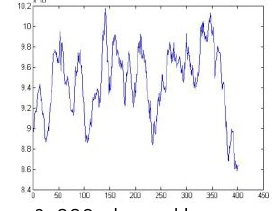
Figure 3. SSG changed by a